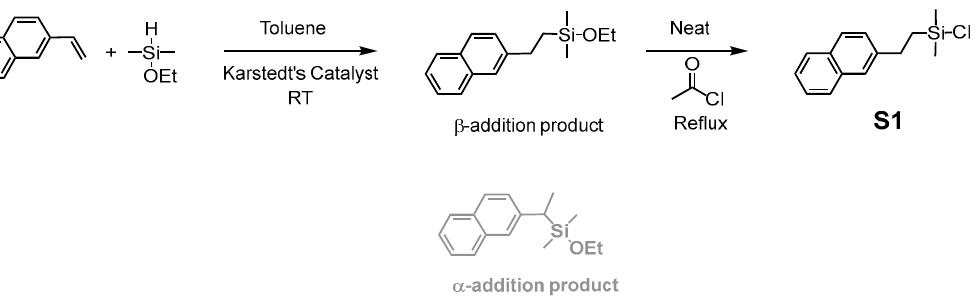
Figure 3. Synthesis of chlorodimethyl(2-naphthylethyl)silane ( S1 ). The by-product resulting from α -addition is shown in gray (removed by flash chromatography prior to reaction with acetyl chlo- ride).